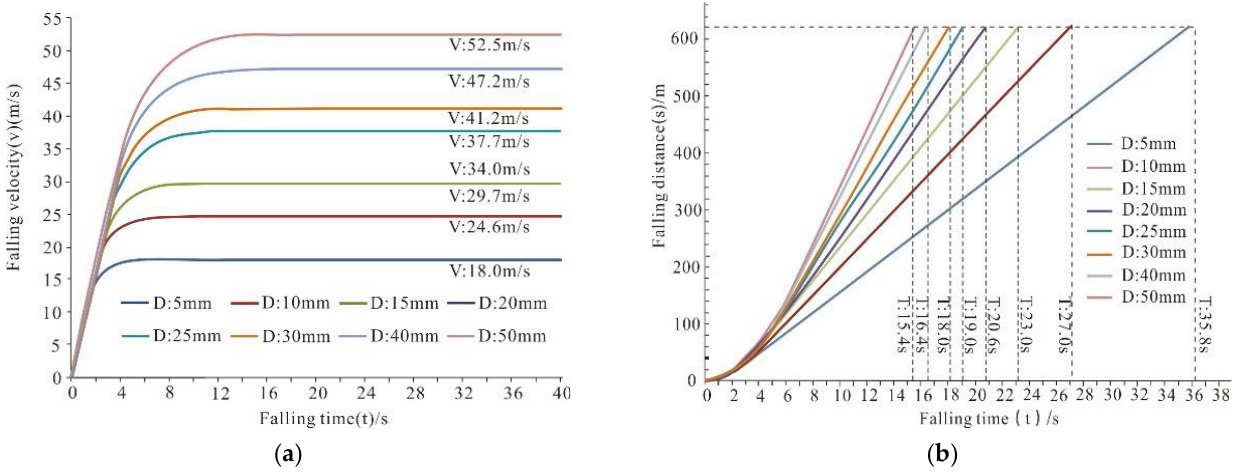
Figure 27. ( a ) The relationship between grain sizes of gangue; ( b ) running speed and time in the vertical pipeline.